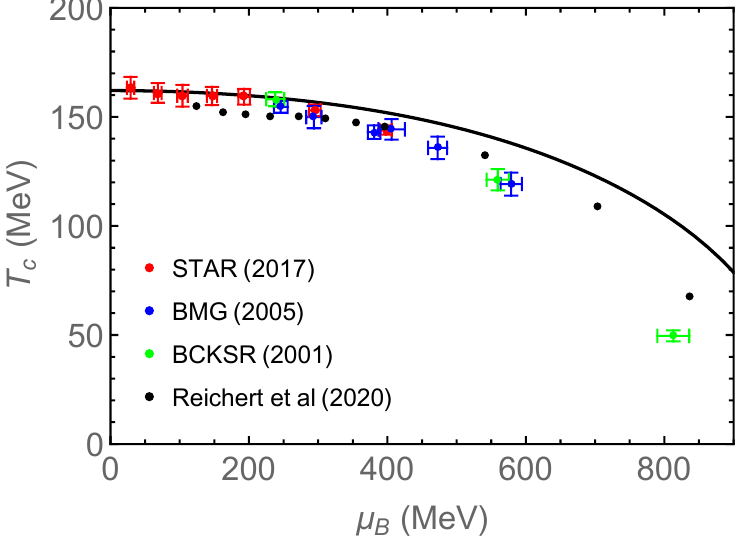
Figure 1. Chemical potential and temperature at chemical freeze-out, determined by thermal model fits to strange hadron yield ratios for data from AGS, RHIC, and LHC experiments [30,32,33]. The STAR experiment data (red) are for 0–10% central collisions. The black dots show the freeze-out parameters obtained from simulations using a hadronic transport model [34]. Blue (BMG) and green (BCKSR) dots are calculations by Becattini et al. from Refs. [31,35], respectively (denoted after the authors’ names). The solid line shows the hadron gas phase boundary obtained in the statistical bootstrap model with excluded volume (see Section 4